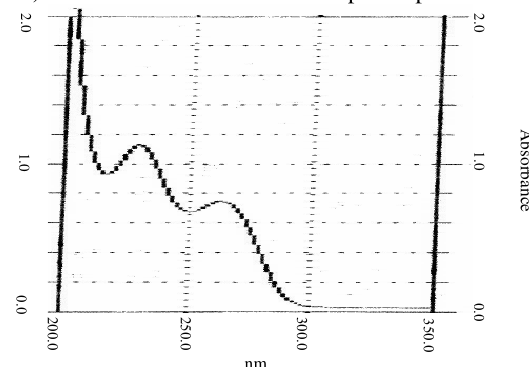
Figure 2. UV/VIS absorption spectrum of cefadroxil in water (25